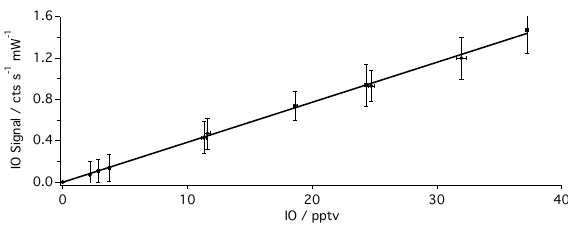
Fig. 2. Calibration of IO for mixing ratios between 2.2 and 37.2pptv. From this fit, the sensitivity of the instrument ( C IO ) is 0.039 ( ± 0.001)ctss − 1 mW − 1 pptv − 1 , with a slight negative